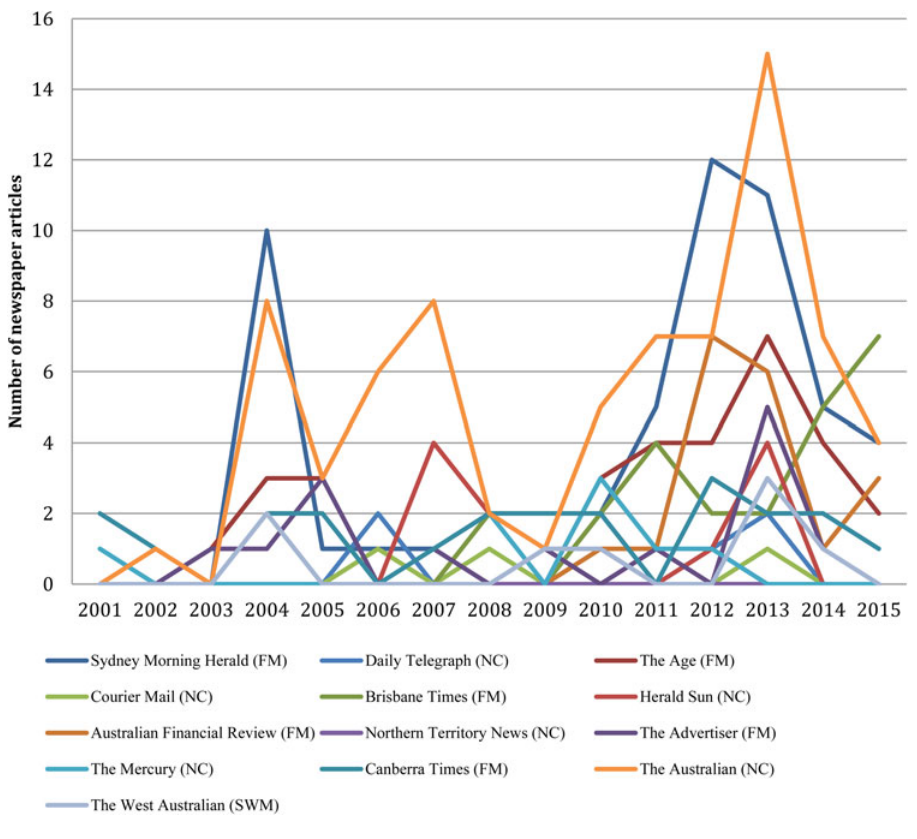
Fig. 3. Number of Australian PISA newspaper articles between 2001 and 2015 ( n